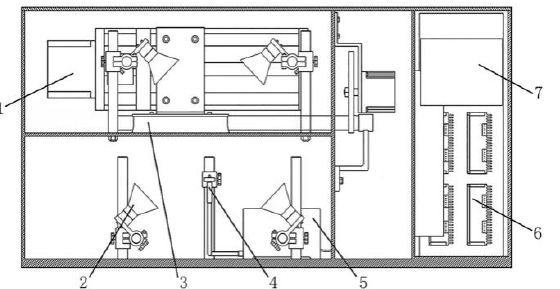
Figure 1. Equipment for visible and near-infrared spectral measurements. 1. Ball screw. 2. Tungsten halogen lamp. 3. Sample room. 4. Optical fiber. 5. NIR spectrometer. 6. The computer control unit. 7. Monitor.